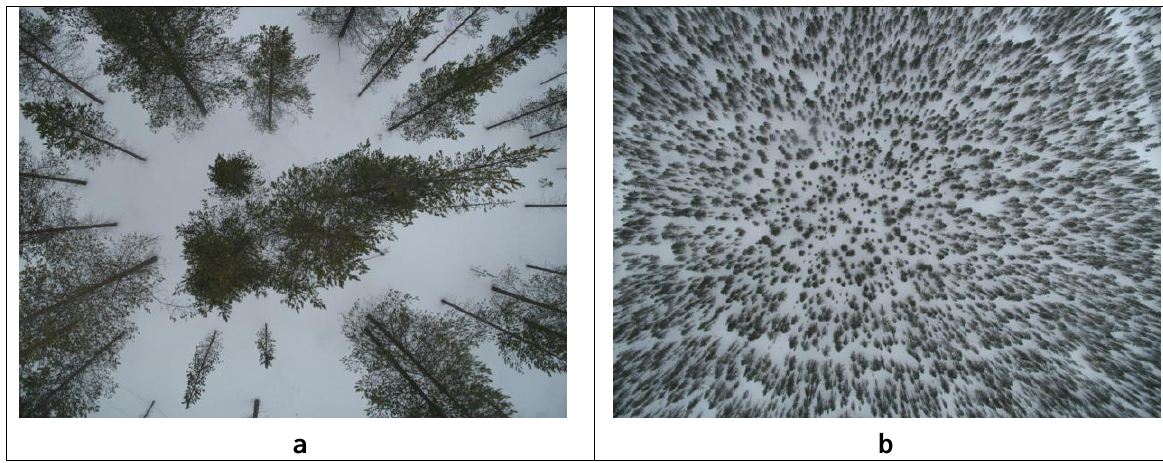
Figure 4. Example of photos of one vertical profile taken at Kommattivaara (67.440° N, 26.745° E) in March 13, 2009 using the wide optics airborne camera. (a) Altitude above ground about 25 m, (b) altitude above ground about 210 m. The corresponding thresholded binary images are shown